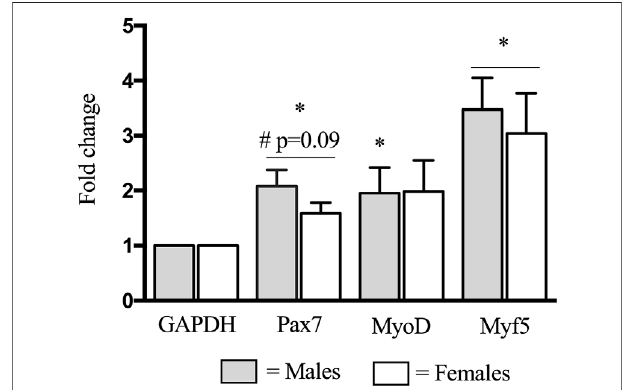
FIGURE 5 | Changes in Pax7, MyoD, and Myf5 mRNA expression before (pre-) and 48 h (post) following eccentric damage. Fold changes for mRNA expression were calculated using the 2 − ΔΔ C t method with genes of interest normalized to GAPDH. * indicates signi fi cant effect of time ( p < 0.05). # indicates signi fi cant time × group interaction; an increase from pre- exercise value is smaller in females compared with males ( p <